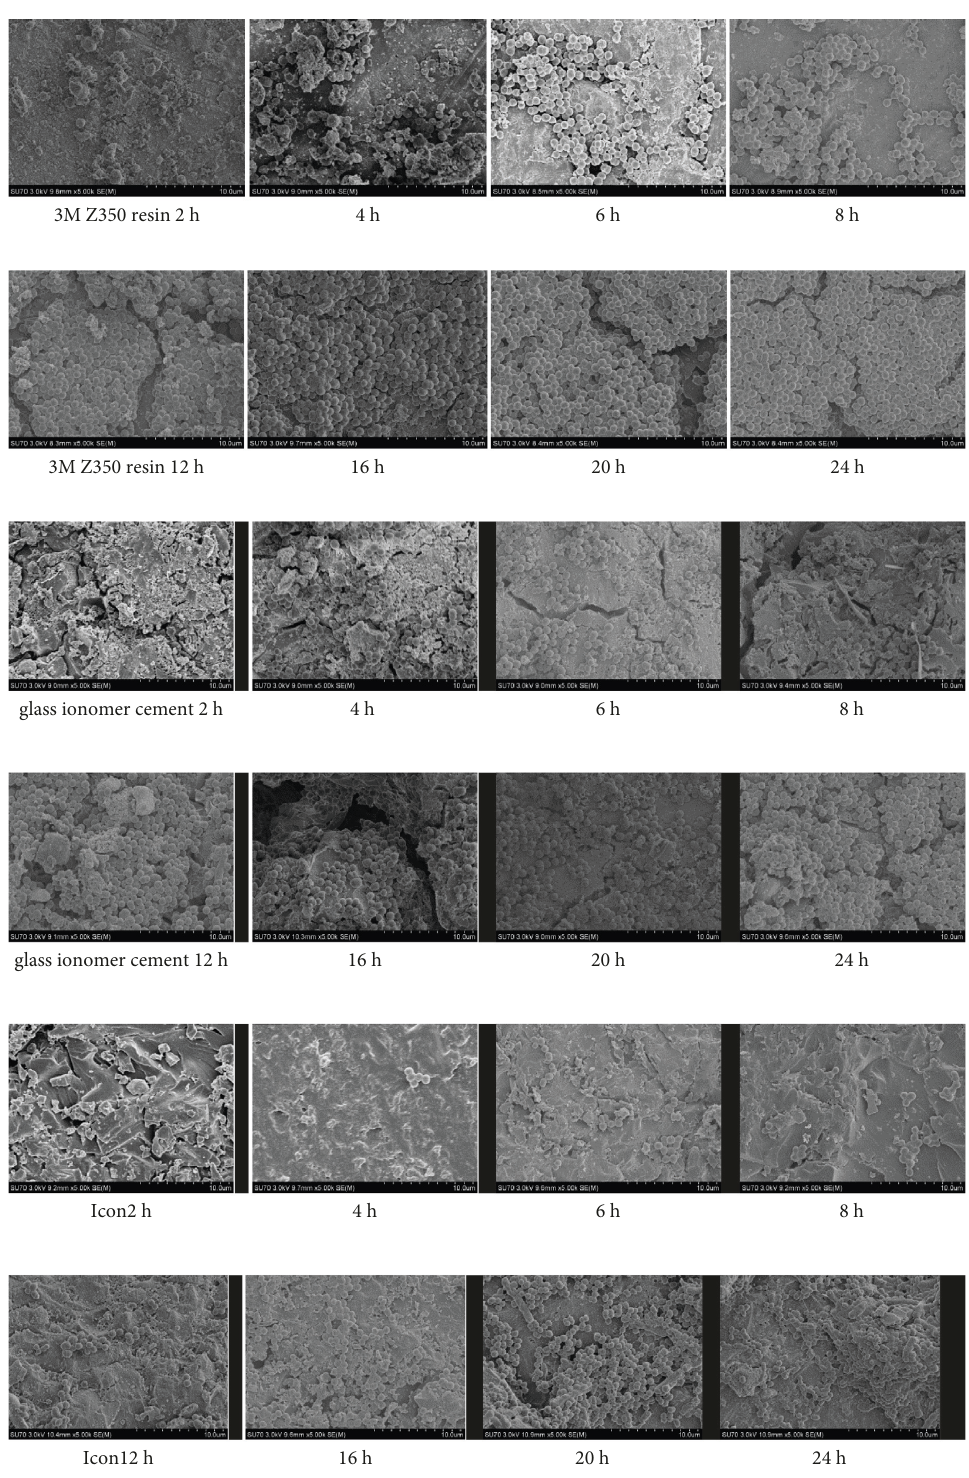
Figure 6: Electron microscopy pictures of the Actinomyces viscosus